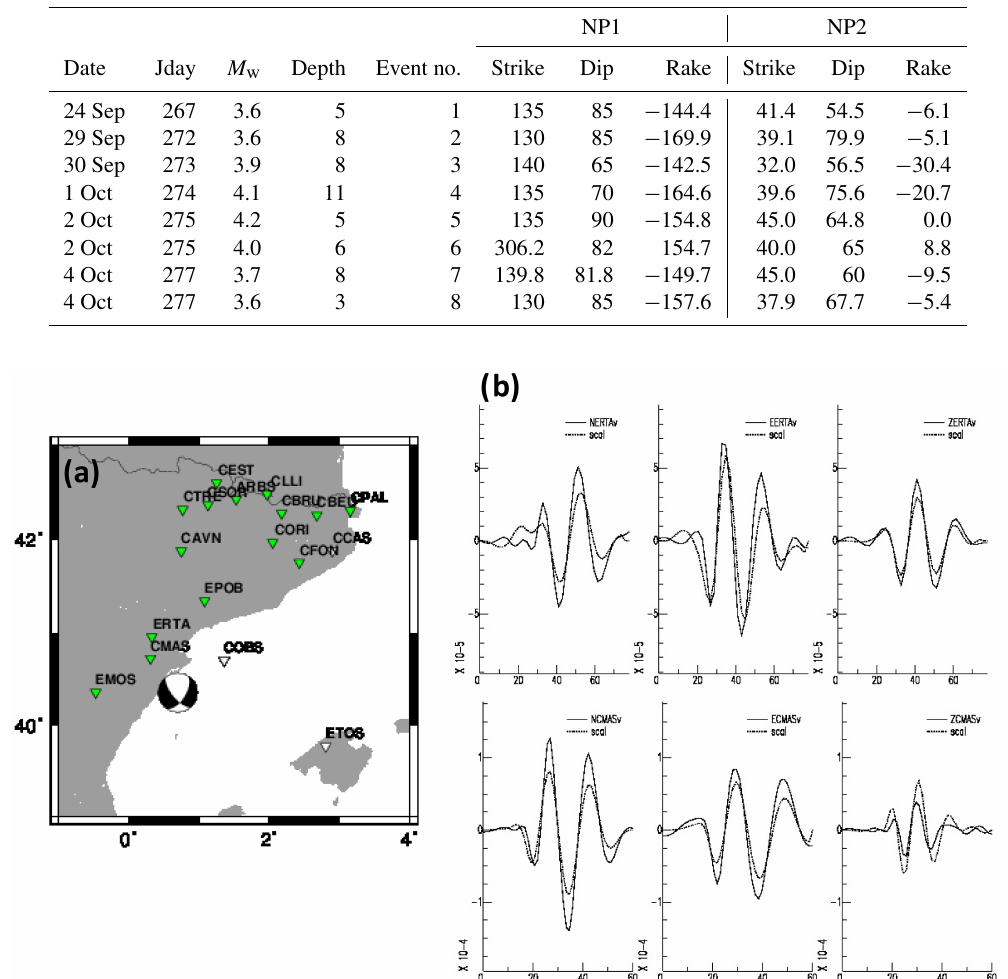
Table 1. FM solutions summary showing both NP families (1 and 2) as referred to in the text and other figures.